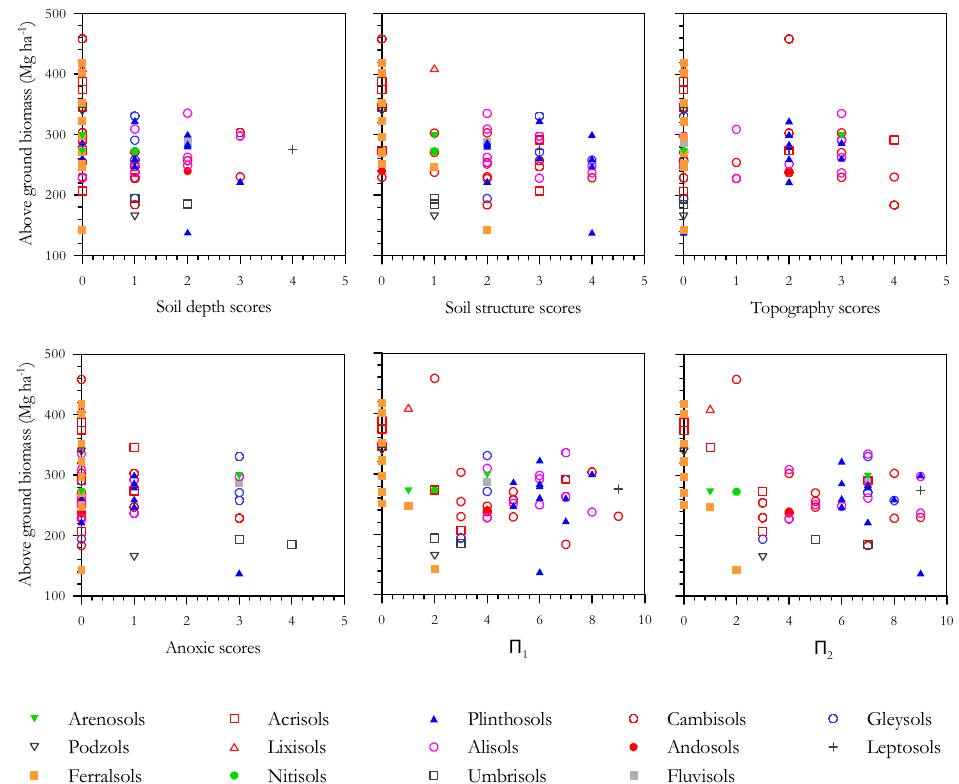
Fig. 13. Relationships between above-ground biomass and soil physical properties. For definitions of 5 1 and 5 2 see Sect.